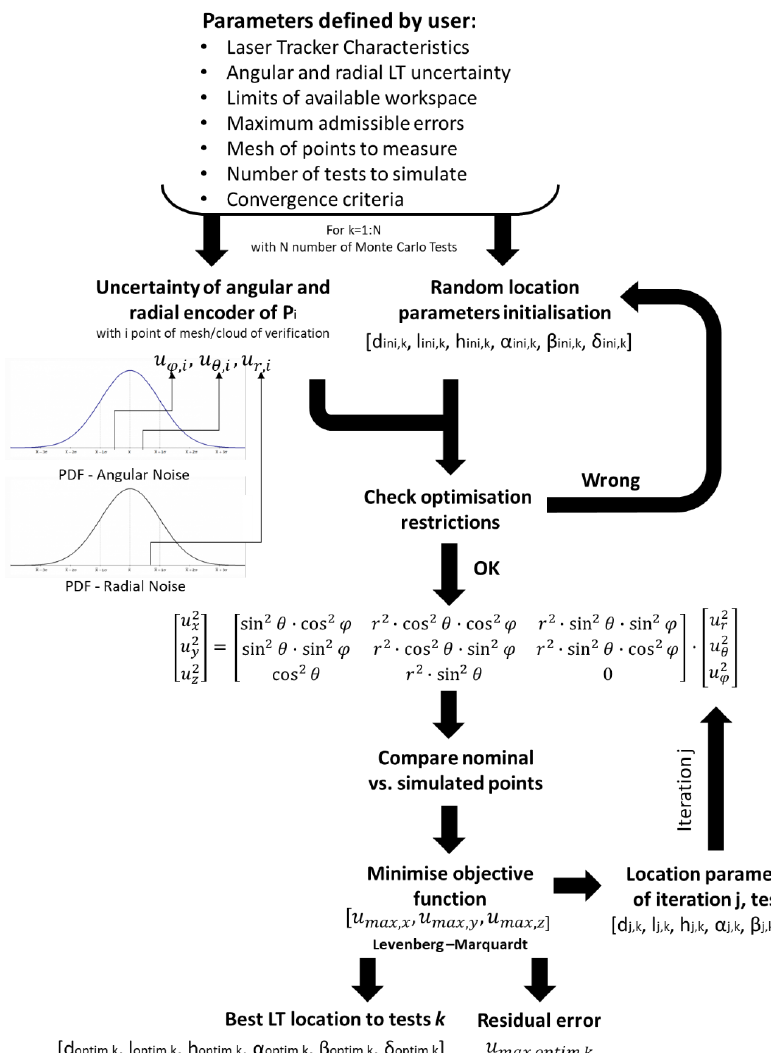
Figure 3. Working principle of the location algorithm.